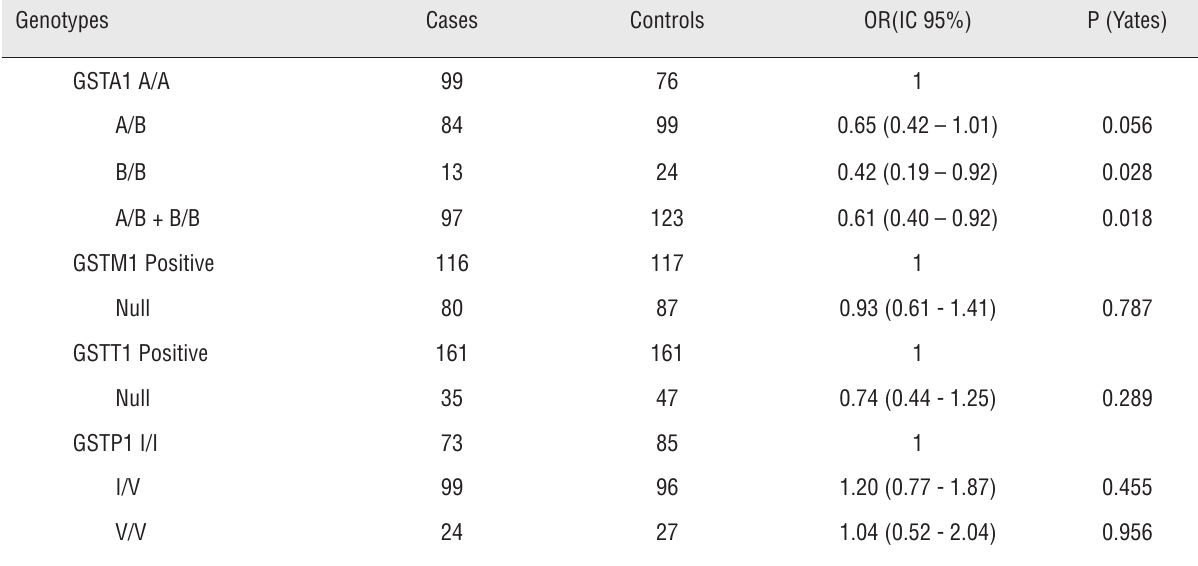
Table 3 - Analysis of association between genetic polymorphisms and the risk of Prostate Cancer. Genotypes Cases Controls OR(IC